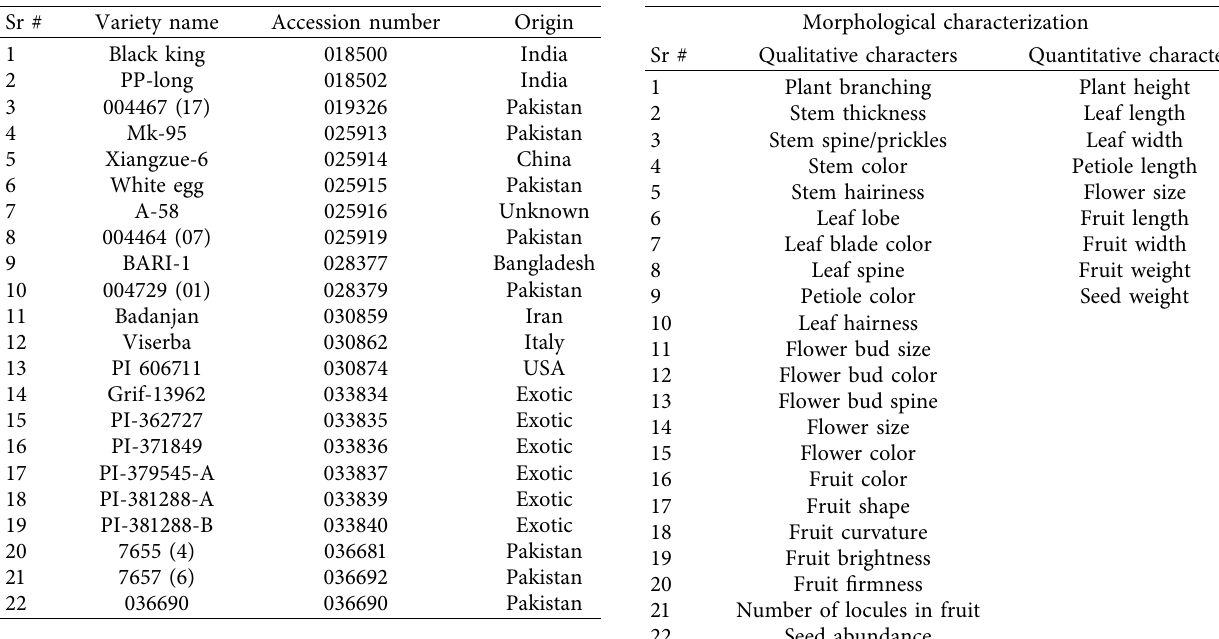
Table 2: Qualitative and quantitative traits for diversity analysis among eggplant varieties.